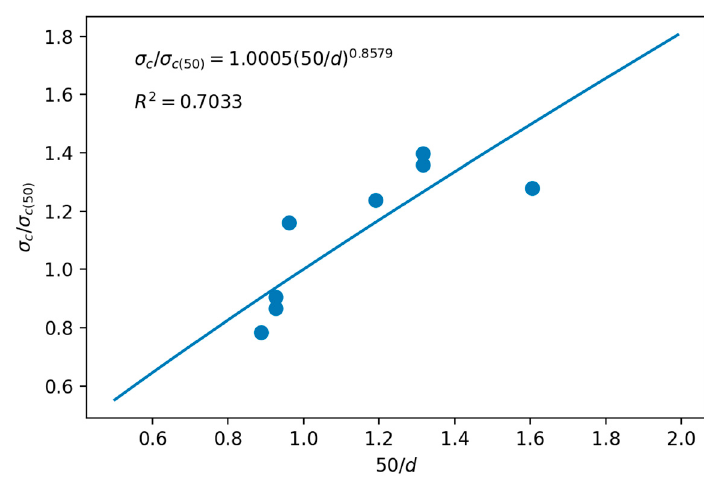
Figure 12. Scale effect curve for the σ c of travertine.